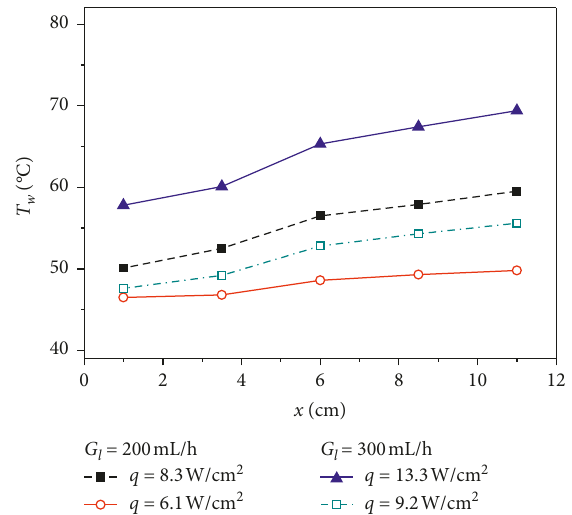
Figure 9: Wall temperature of microchannels (liquid inlet tem- perature of 25 °